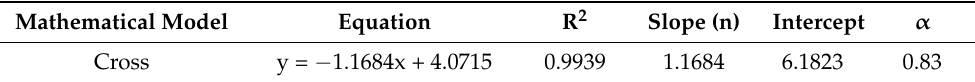
Table 6. Equation, correlation coefficient (R 2 ), slope, and intercept values of the linear regressions obtained by fitting the rheogram data to the Cross mathematical model.